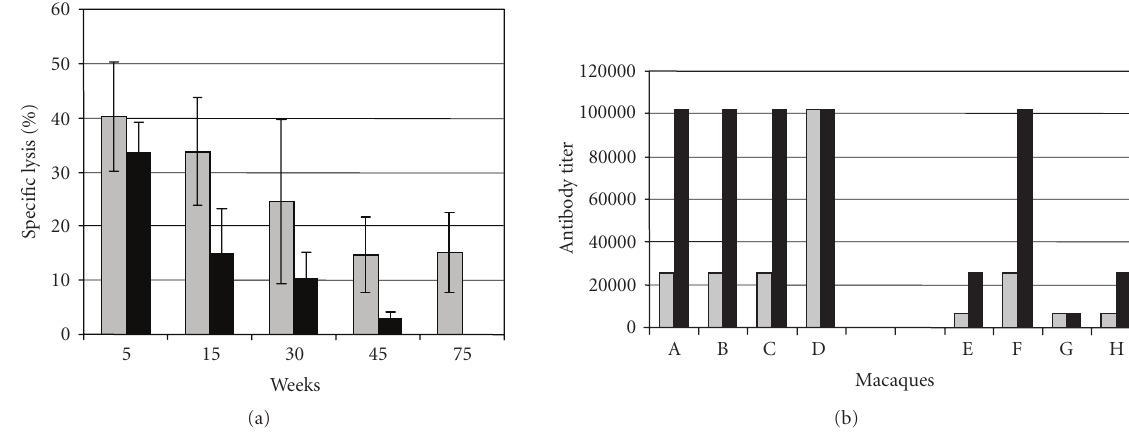
Figure 3: Cellular and humoral immune responses to SIV are enhanced by anti-FasL treatment. MHC-restricted CTL to SIV p27 Gag protein (Panel A) were measured in a standard 4 hours. 51 Cr-release assay [26]. Targets were syngeneic B-LCL (di ff erent lines for each animal) that were either uninfected or infected with VVgag as described [26]. Percent specific lysis at the 50:1 e ff ector to target ratio was plotted. The mean and standard errors of the mean (SEM) are shown for four animals treated with anti-FasL (shaded bars) or four control macaques (solid bars) at the times indicated. The values for CTL activity were consistently higher among macaques treated with anti-FasL compared with controls, but the di ff erences were not significant at 30 weeks after infection. Virus binding titers (Panel B) were measured by ELISA using plates coated with p27 Gag antigen as described [27]. Sera from weeks 12 (shaded bars) or 24 (solid bars) were diluted with normal saline, up to a maximum dilution of 1:100,000. Macaques (A, B, C, D) on the left side of the figure had been treated with anti-FasL, and macaques (E, F, G, H) on the right side had been treated with control IgG. Anti-FasL treatment caused a substantial elevation in virus-binding antibodies in SIV-infected macaques, which have been shown to correlate with reduced disease progression [28].